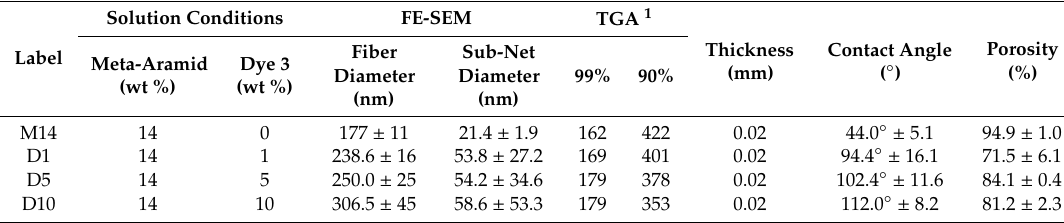
Table 1. Labels and basic properties of each meta-aramid/dye 3 nanofiber composition.